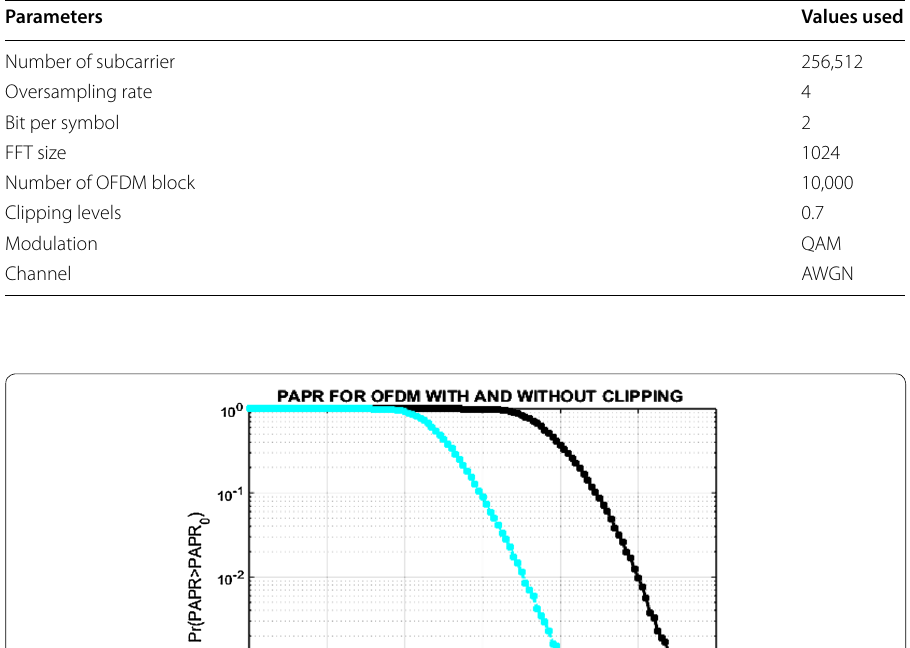
Table 1 Simulation parameters for the clipping technique